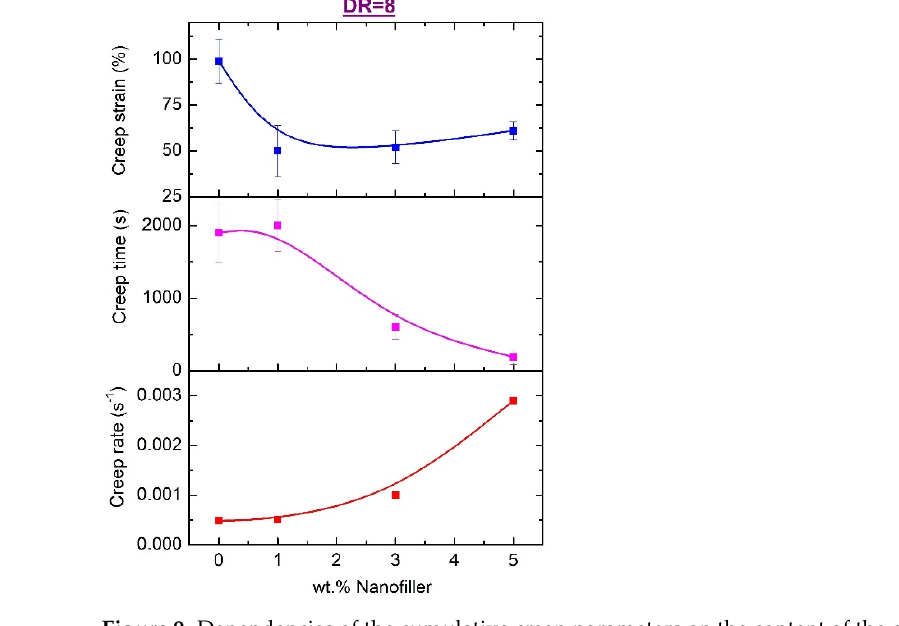
Figure 9. Dependencies of the cumulative creep parameters on the content of the carbon nanodiscs in the oriented composite HDPE-based fibers.